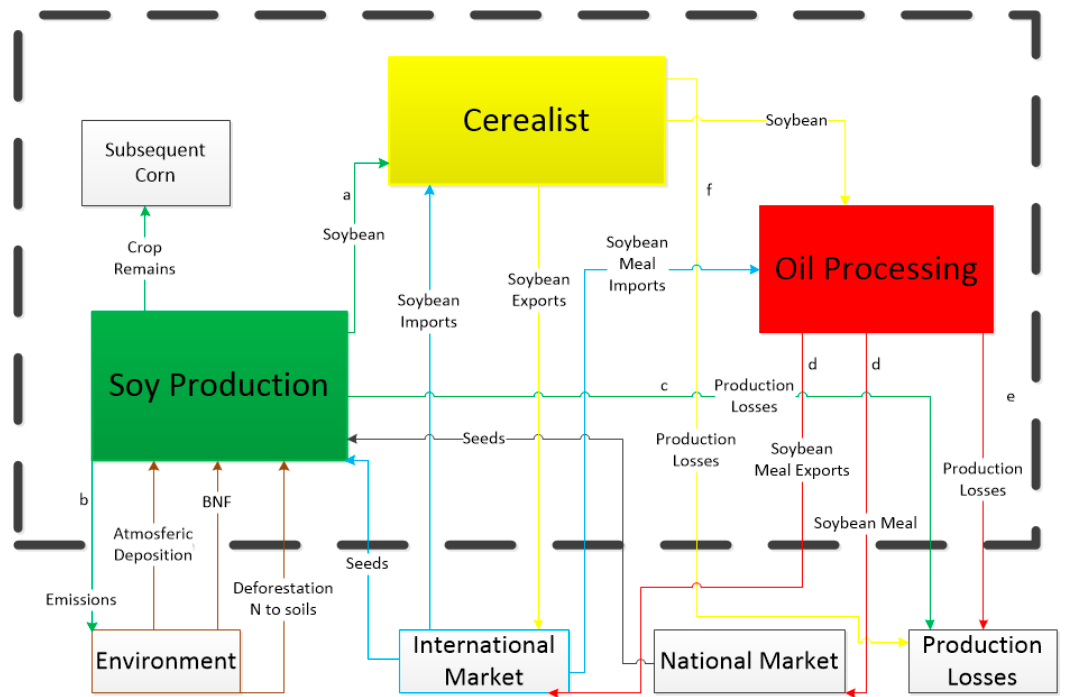
Figure 1. Nitrogen flows on soybean production chain in Brazil from of 2007 to 2019. The colors of the arrows represent the source of the nitrogen flow output. The dotted rectangle represents the boundary of the system considered in this model. BNF stands for biological nitrogen fixation. The letters a, b, c, d, e, f correspond to the flows considered for calculating the nitrogen cascade indicator (NCI).